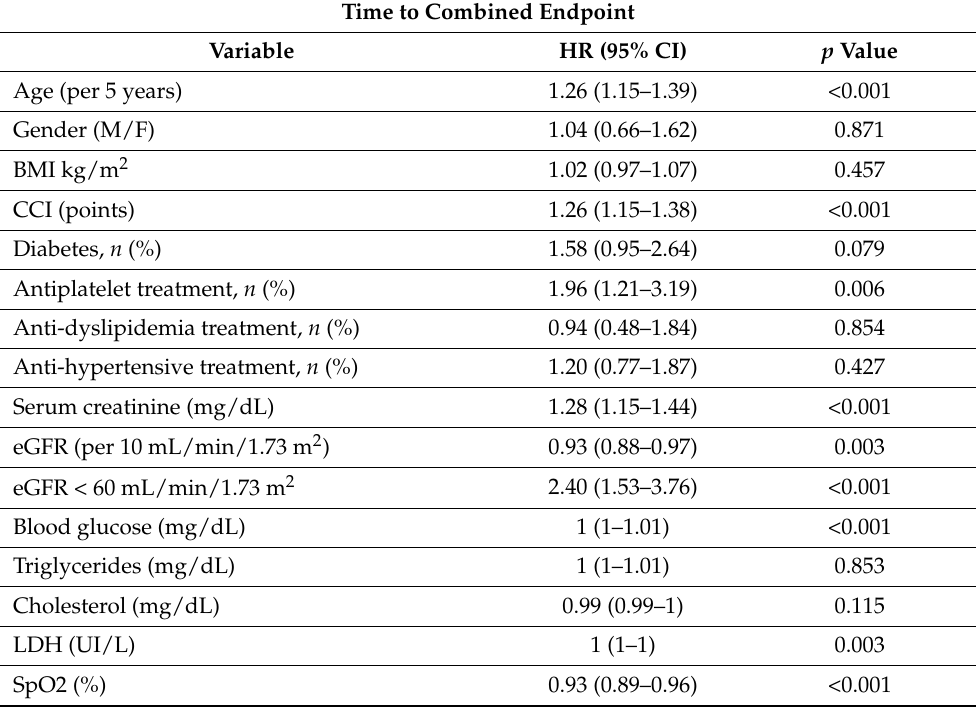
Table 2. Results of Cox univariate regression analysis for characteristics associated with the main outcome (death + admission to